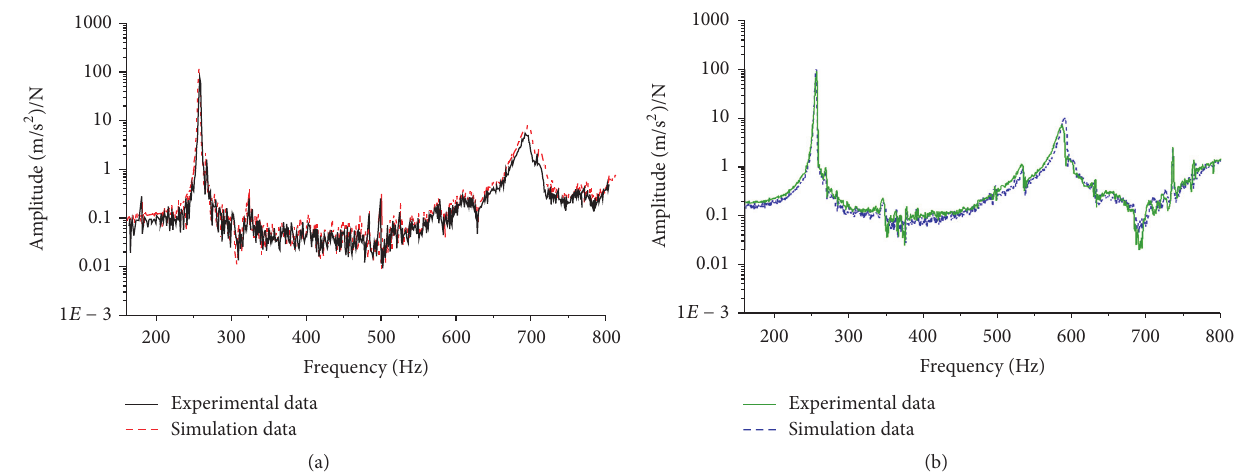
Figure 21: Comparison of frequency response functions obtained by experiential data and finite element analysis results at torque = 8 N ⋅ m. (a) The double shear lap beam jointed with 4 screws. (b) The similar beam structure consisting of narrower plates jointed with 2